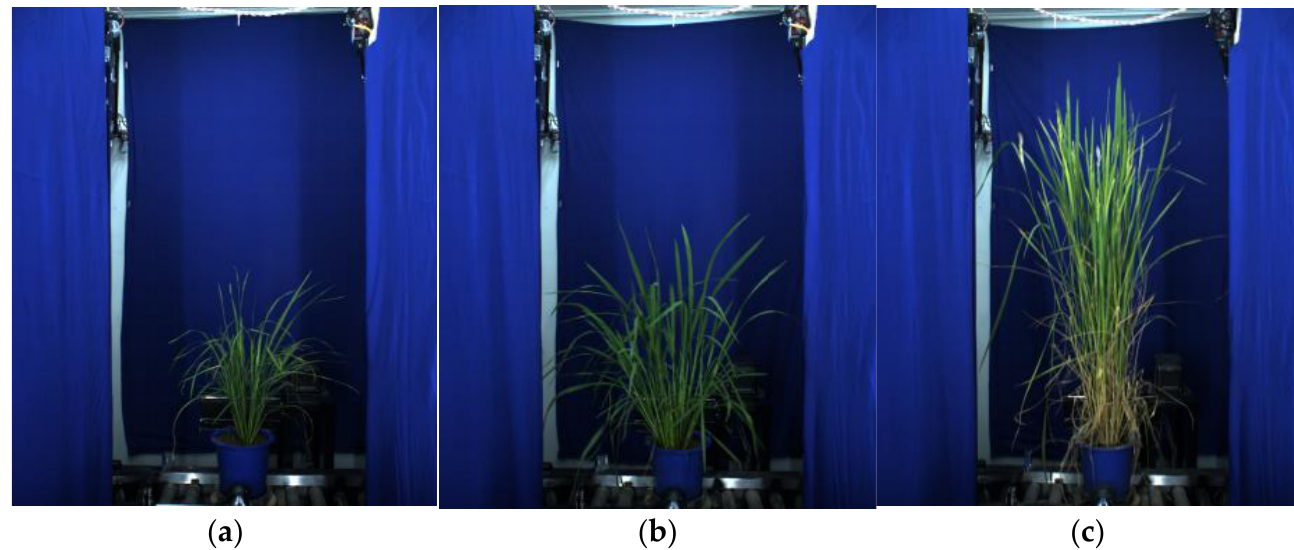
Figure 1. Sample RGB images of rice growth in three stages. ( a ) shows the tillering stage of rice; ( b ) shows the jointing stage of rice; ( c ) shows the heading and grain-filling stage of rice.